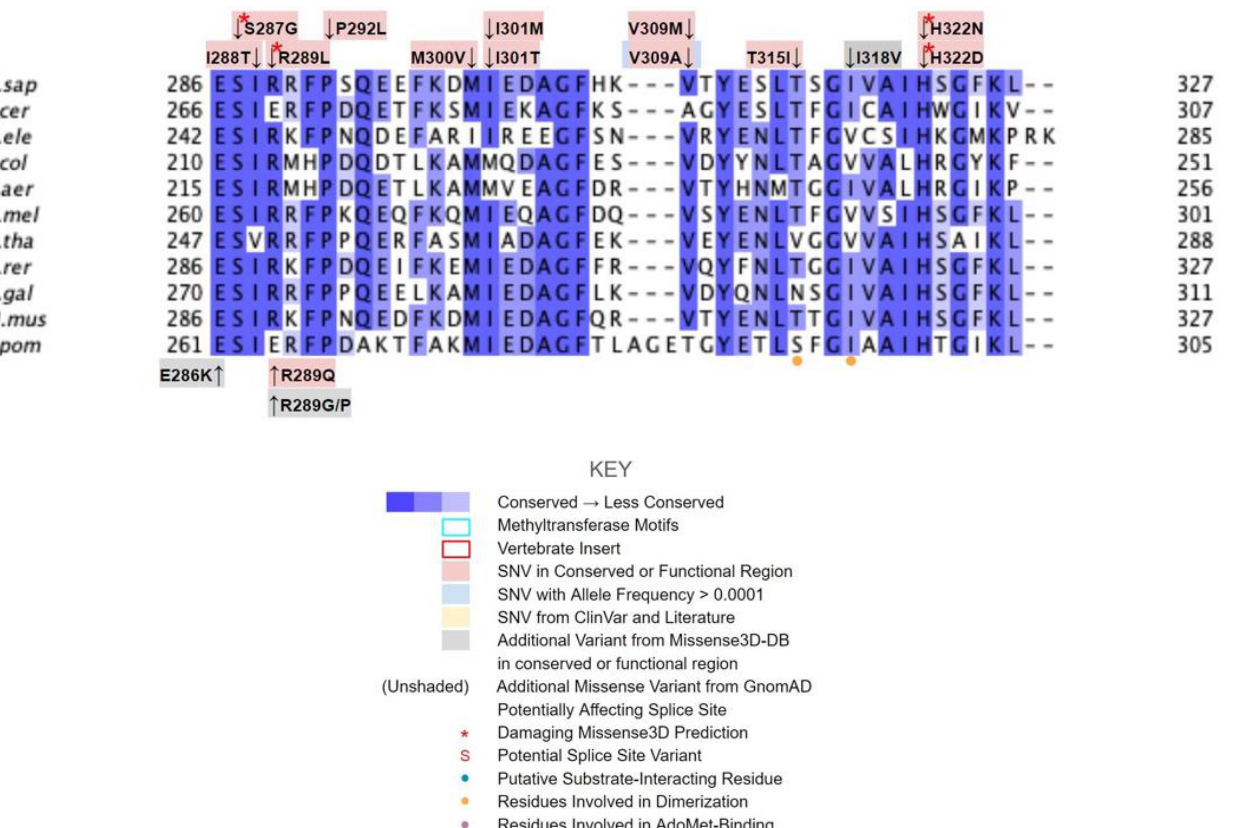
Figure 12. Labeled and annotated multiple sequence alignment of COQ5. Amino acid sequences of COQ5 were analyzed as described in Materials and Methods and include Homo sapiens (NCBI accession number NP_115690.3) and homologs in Saccharomyces cerevisiae (NP_013597.1), Caenorhabditis elegans (NP_498704.1), Escherichia coli UbiE (YP_026260.1), Pseudomonas aeruginosa UbiE (NP_253750.1), Drosophila melanogaster (NP_572865.1), Arabidopsis thaliana (NP_200540.1), Danio rerio (NP_001004541.1), Gallus gallus (NP_001006194.1), Mus musculus (NP_080780.1), and Schizosaccharomyces pombe (NP_587834.1). See KEY for descriptions of the figure annotations. Functional residues (dotted) were determined from the yeast Coq5 crystal structure (data from [48]). Methyltransferase motifs I, post-I, II, and III are boxed in cyan (data from [18]). An insert exclusively found in vertebrate